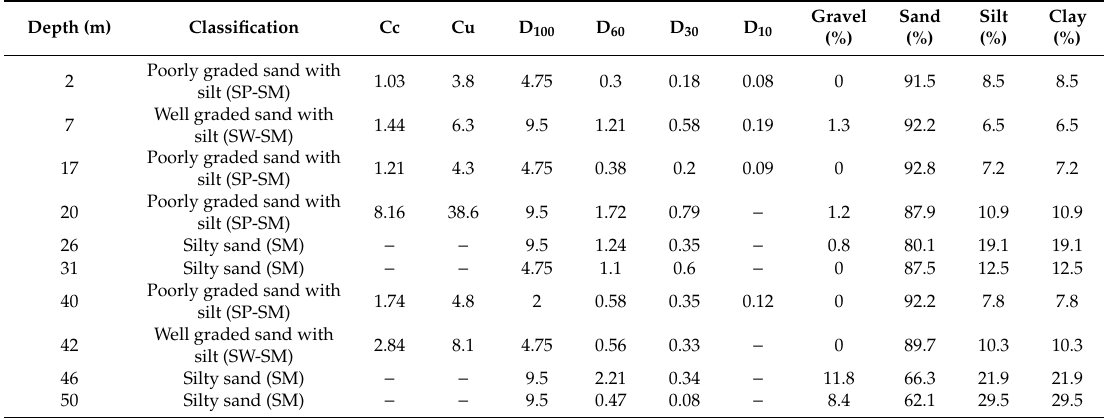
Table 3. Sieve test and grain number (Jubail).